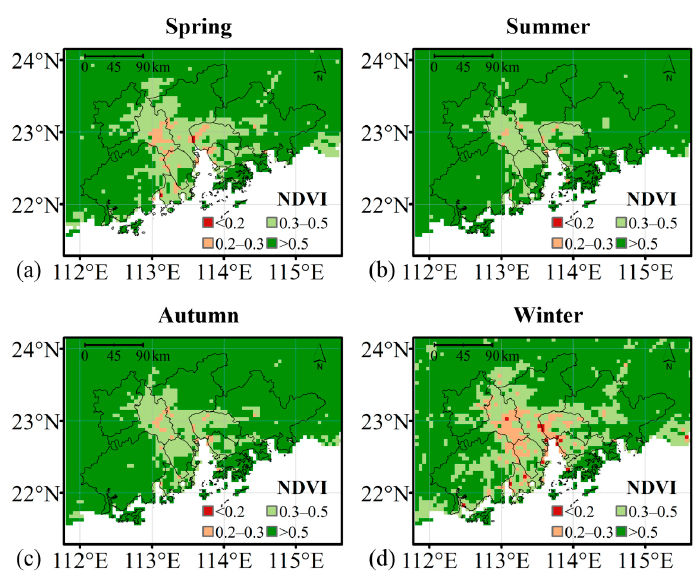
Figure 8. Spatial coverage of multiyear mean AOD derived from ( a ) Terra and ( b ) Aqua DTDB 10 km AOD products for 2006–2015. Pixels covered by the DTDB 10 km AOD are marked in grey. Green and red pixels indicate the regions where valid DT 10 km or DB 10 km retrievals, respectively, are not included in the DTDB 10 km product.